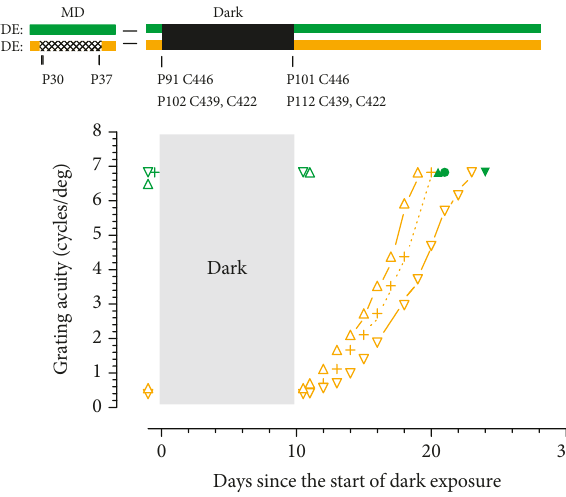
Figure 1: The grating acuity of the two eyes of 3 monocularly deprived kittens immediately prior to and following a 10-day period spent in complete darkness. Each kitten received a 7-day period of MD starting at P30 days and were placed in darkness at either P91 days (C446) or at P102 days (C439, C422). As with subsequent fi gures, the visual histories and acuity data in the graphs below for the deprived eye (DE) and nondeprived eye (NDE) are depicted in orange and green, respectively. Occlusion of the DE during the early period of MD is shown by crosshatching, and the subsequent period of total darkness is indicated in black. The results of acuity measurements for the 3 animals are depicted by symbols as follows: C422 upright triangles, C446 plus symbols or solid circles (NDE), and C439 inverted triangles. The results of binocular measurements of acuity are shown as open green symbols while monocular measurements of the acuity of the nondeprived eye acuity with which they are equivalent are shown as solid green